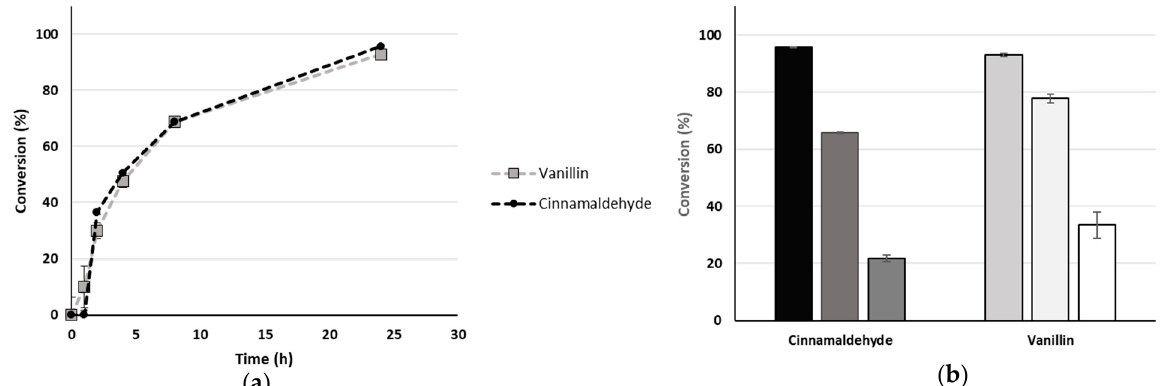
Figure 4. Conversion of cinnamaldehyde and vanillin to their corresponding amines in the dialysis system. ( a ) Conversion over time for the first cycle. ( b ) The reusability of the system is shown. The reaction mixture contained 10 mM of the corresponding aldehyde, 10 mM L-alanine, 250 mM ammonium formate, 1 mM NAD+, 1mM PLP and the enzymatic cocktail contained 1 mg/mL of CvTA, 1 mg/mL of HeAlaDH, and 2 mg/mL of CbFDH. Table 2. Effect of different stabilising agents on the overall yield after 3 cycles of the dialysis assisted scale up. Reactions consisted of 4 mL of 10 mM cinnamaldehyde, 1 eq. of L -alanine, 250